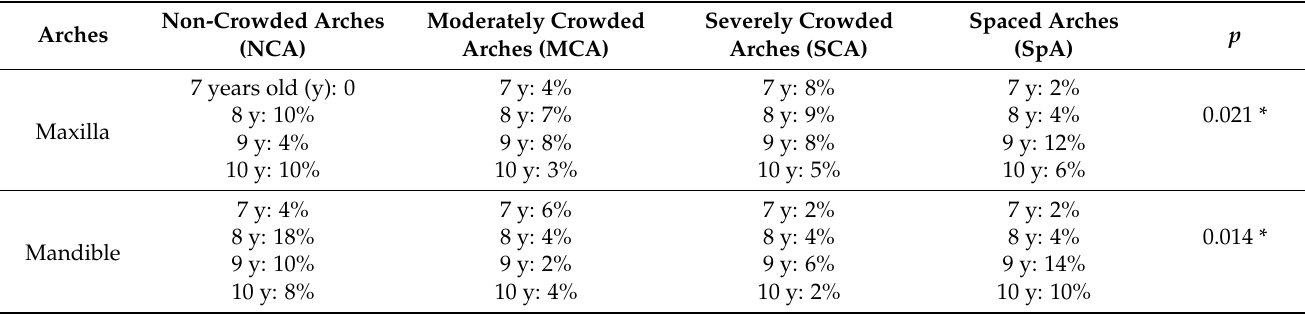
Table 3. Distribution of crowded, non-crowded, and spaced arches in the study group related to age; significant differences among subgroups according to chi-square test.